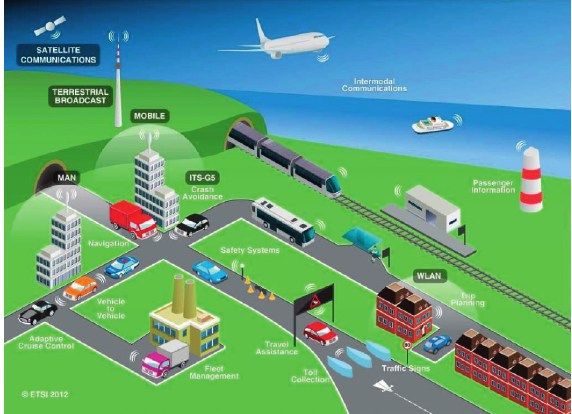
Figure 3: Intelligent transportation systems (ITS) [49].